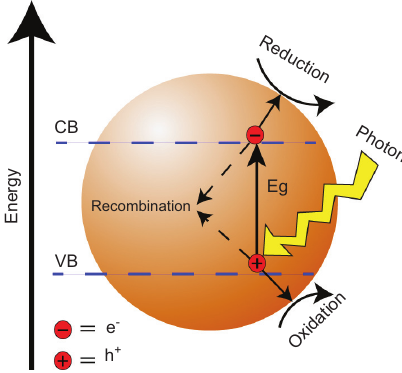
Figure 13 Basic principles of photocatalysis on the semiconductor materials. CB, conduction band; VB, valence